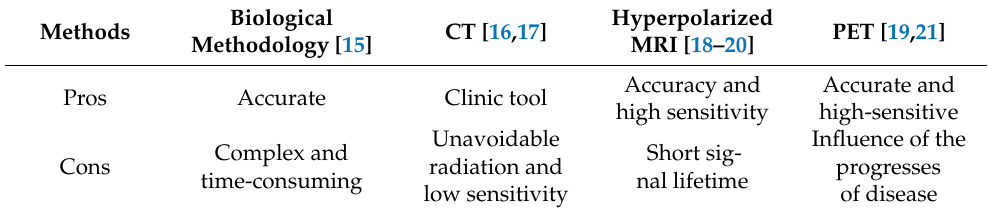
Table 1. The pros and cons of biological methodology and radiological technology in biomedicine.